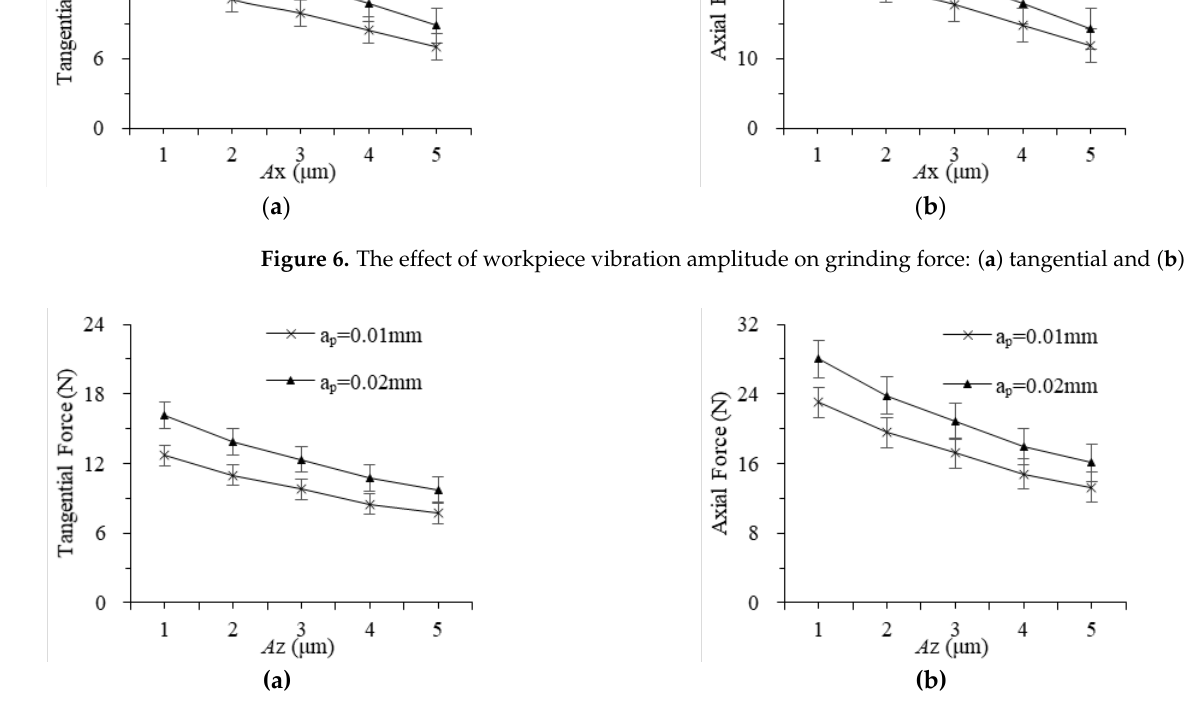
Figure 7. The effect of tool vibration amplitude on grinding force: ( a ) tangential and ( b ) axial.